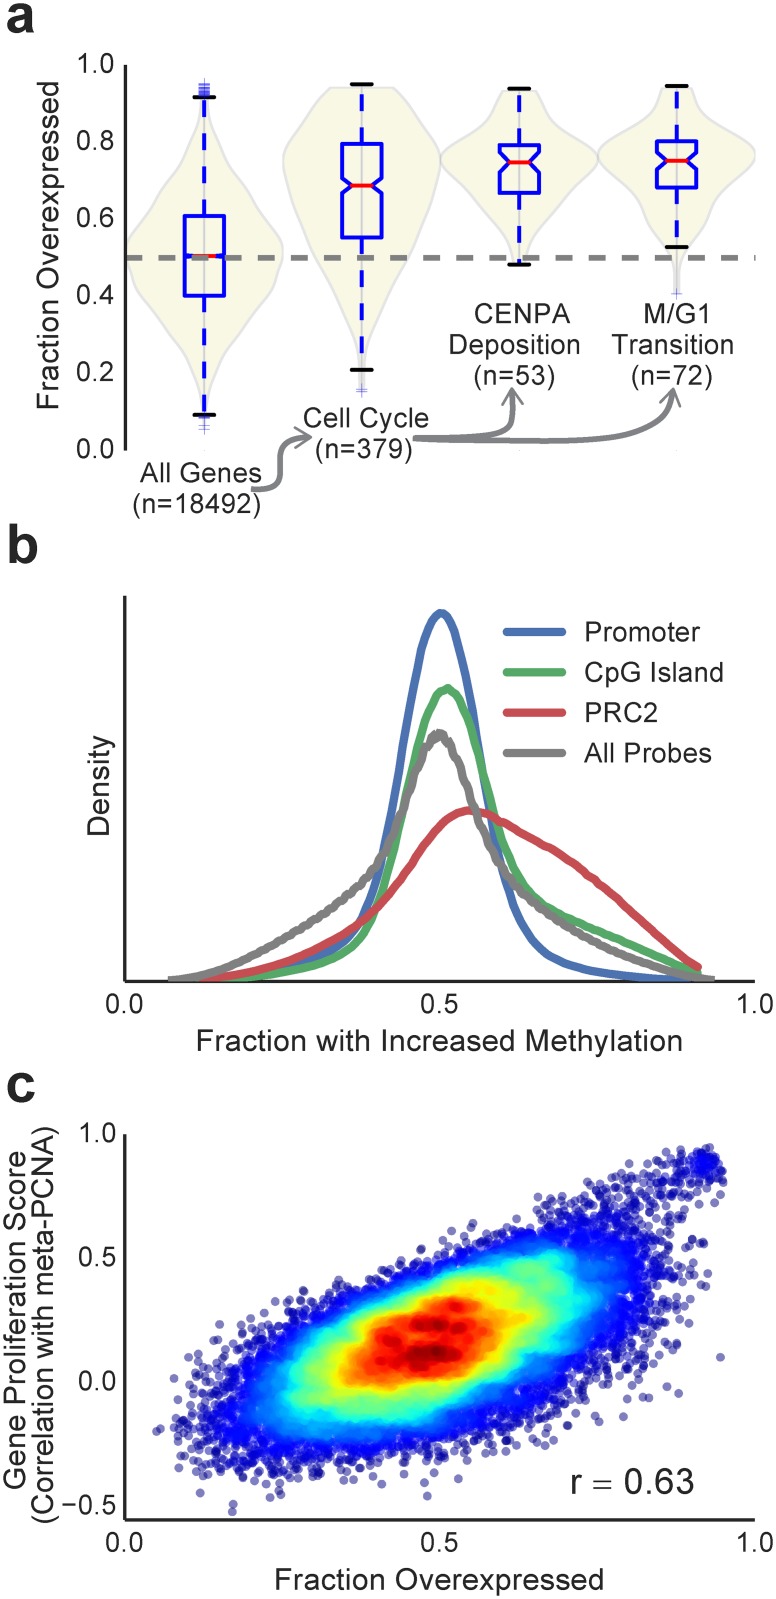
Tumor-associated features are consistent with proliferative signals.(a) Violin plots showing distribution of mRNA level f
up statistic (fraction overexpressed) across all genes, compared to genes annotated to the cell cycle and its subsets: “deposition of CENPA containing nucleosomes at the centromere” and “M/G1 transition” in mSigDB. (b) Density plots of the distribution of f
up (fraction with increased methylation) across methylation markers annotated to functional genomic sites. (c) Scatter plot comparing f
up statistic against gene correlation with proliferation for every gene expression profile.